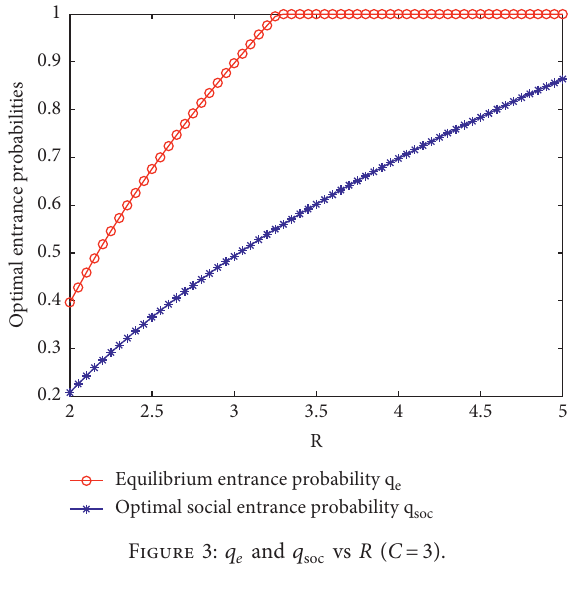
q vs R ( C � e and soc